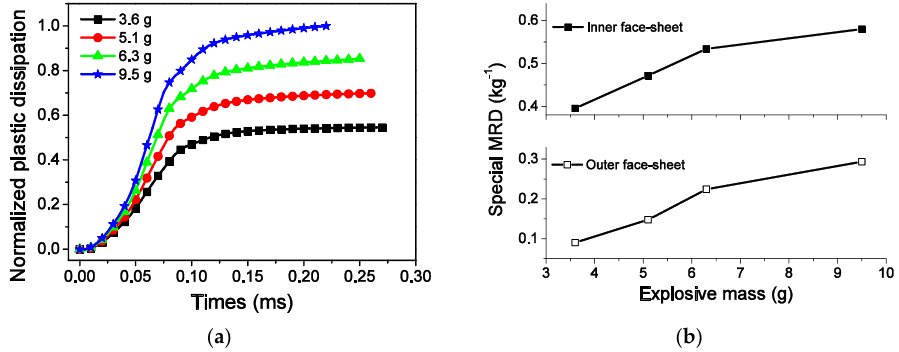
Figure 17. Influence of explosive mass on energy absorption (EA) and MRD. ( a ) EA, and ( b ) MRD.